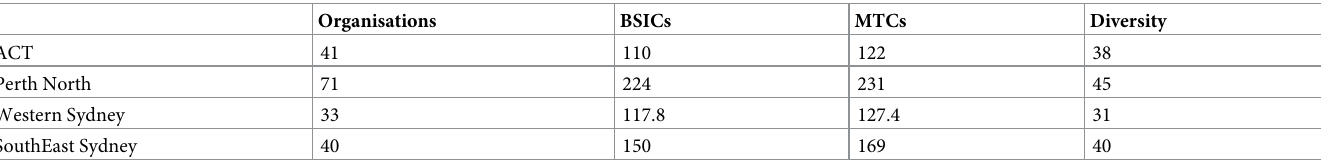
Table 2. Diversity of main types of care: Comparison between Australian regions